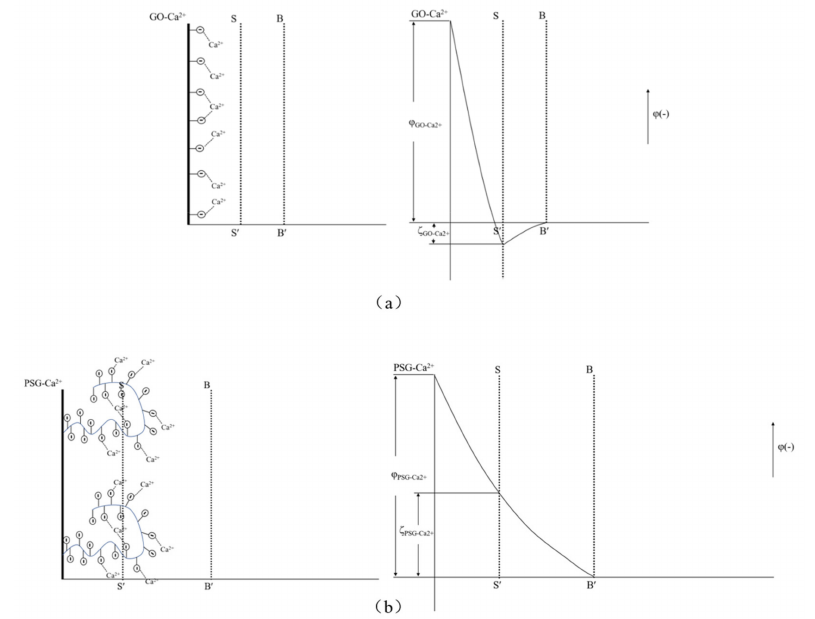
Figure 19. Zeta potential diagram of GO surface in Ca 2+ system and PSG surface in Ca 2+ ion system: ( a ) GO; and ( b )